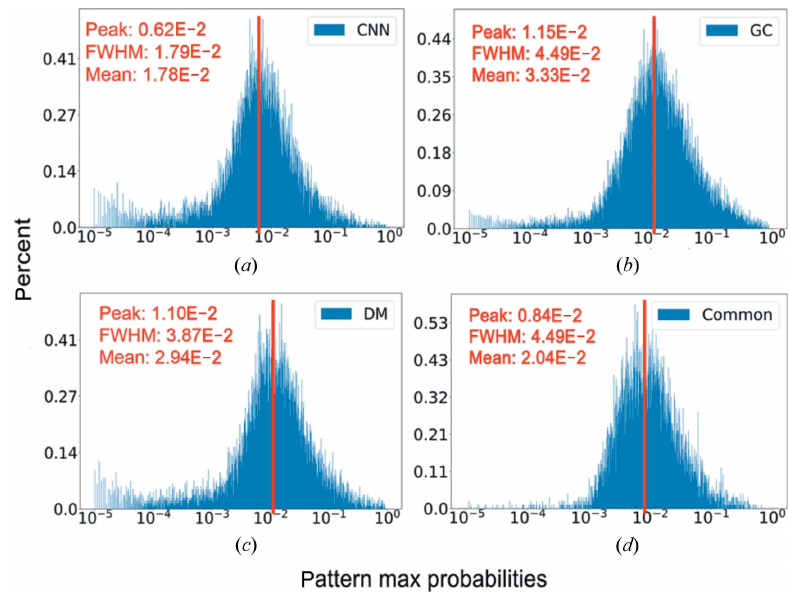
Figure 5 The distributions of the largest probability for each pattern. For randomly sampled orientations, the expected probability should be approximately 2 (cid:4) 10 (cid:5) 5 . For the CNN ( a ) , the GC ( b ) and the DM ( d ) methods, the percentage of patterns whose largest probabilities are smaller than 10 (cid:5) 4 are 7.19, 2.62 and 6.76%, respectively. In comparison, the common dataset ( d ) has 9404 patterns, 28 of which have the largest probability smaller than 10 (cid:5) 4 ( (cid:2) 0.3%).